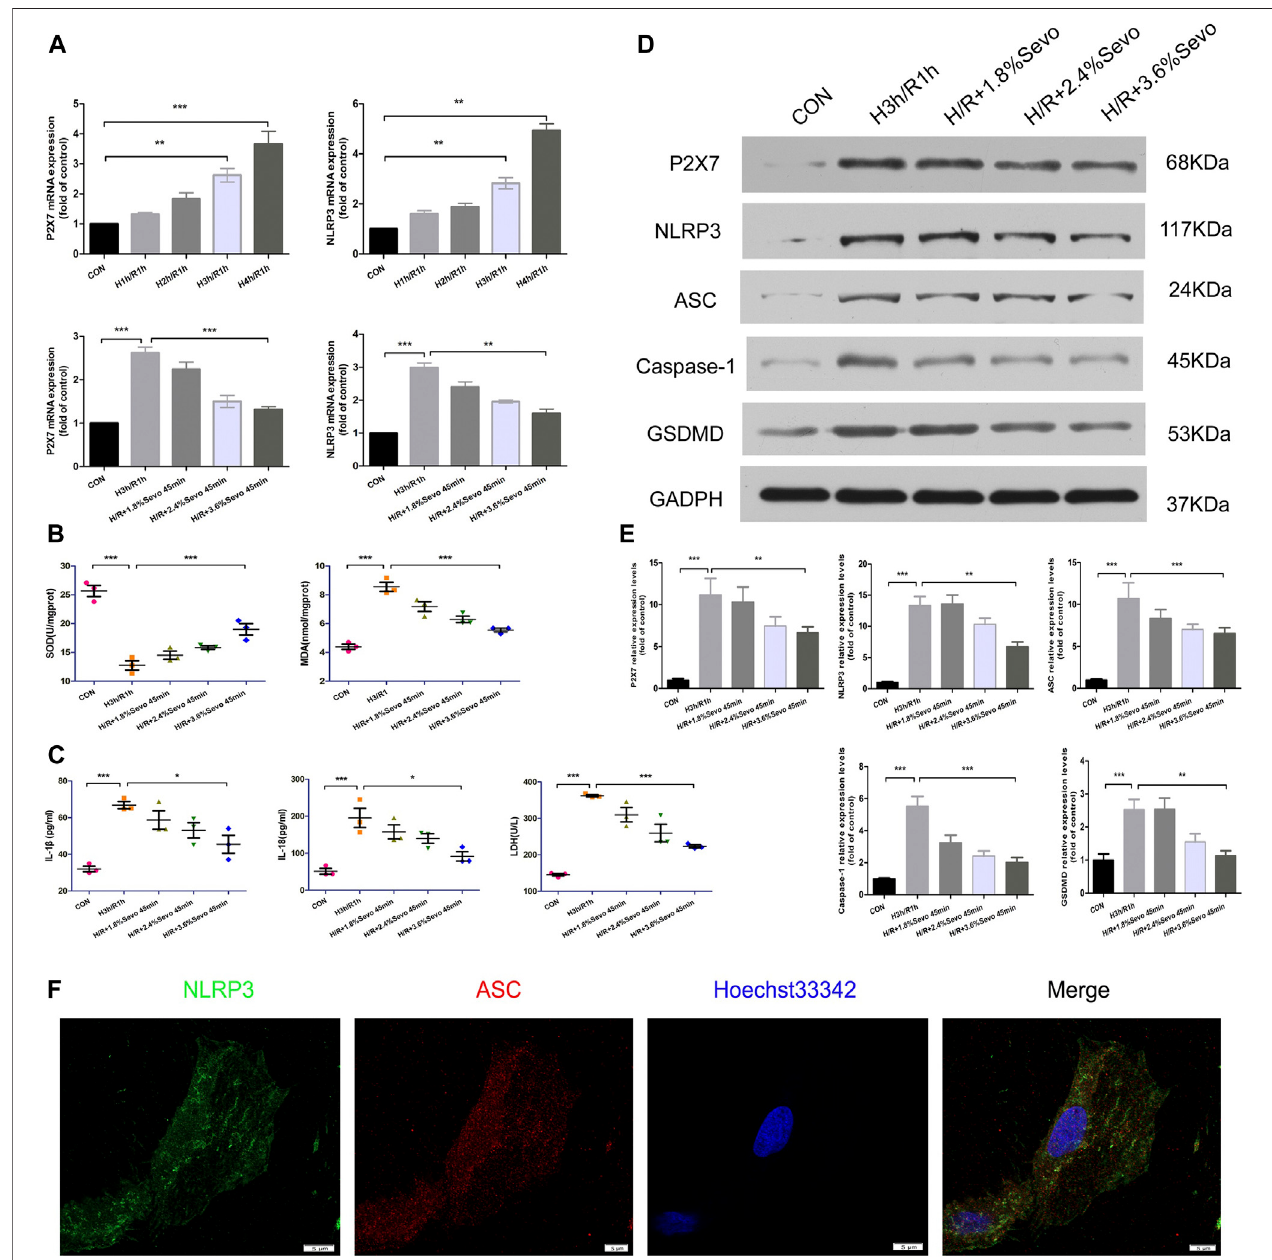
FIGURE6| Sevo fl urane inhibited the activation of in fl ammasome and pyroptosis induced by hypoxia and reoxygenation of NRVM (A) The expression of P2X7 and NLRP3 mRNA detected by real-time PCR. Data are expressed relative to the mean value for control group and were presented as mean ± SD (n (cid:1) 3). * p < 0.05, ** p < 0.01, *** p < 0.001 vs respective controls (B) Effects of different concentrations of Sevo fl urane on the content of MDA and SOD. All values are expressed as mean ± SD (n (cid:1) 3). * p < 0.05, ** p < 0.01, *** p < 0.001 vs respective controls (C) Effects of Sevo fl urane at different concentrations on the release of IL-1 β , IL-18 and LDH in NRVM after H/R. All values are expressed as mean ± SD (n (cid:1) 3). * p < 0.05, ** p < 0.01, *** p < 0.001 vs respective controls (D) Effects of Sevo fl urane at different concentrations on the protein expression of P2X7,NLRP3,ASC,Caspase-1 and GSDMD in NRVM after H/R by immunoblotting analysis (E) Histogram of the protein expression of P2X7,NLRP3,ASC,Caspase-1 and GSDMD. Data are expressed relative to the mean value for control group and were presented as mean ± SD (n (cid:1) 3). * p < 0.05, ** p < 0.01, *** p < 0.001 vs respective controls (F) Colocalization of NLRP3 and ASC in NRVM was observed by the laser scanning confocal microscope(n (cid:1) 3,Scale bars fi ve um).